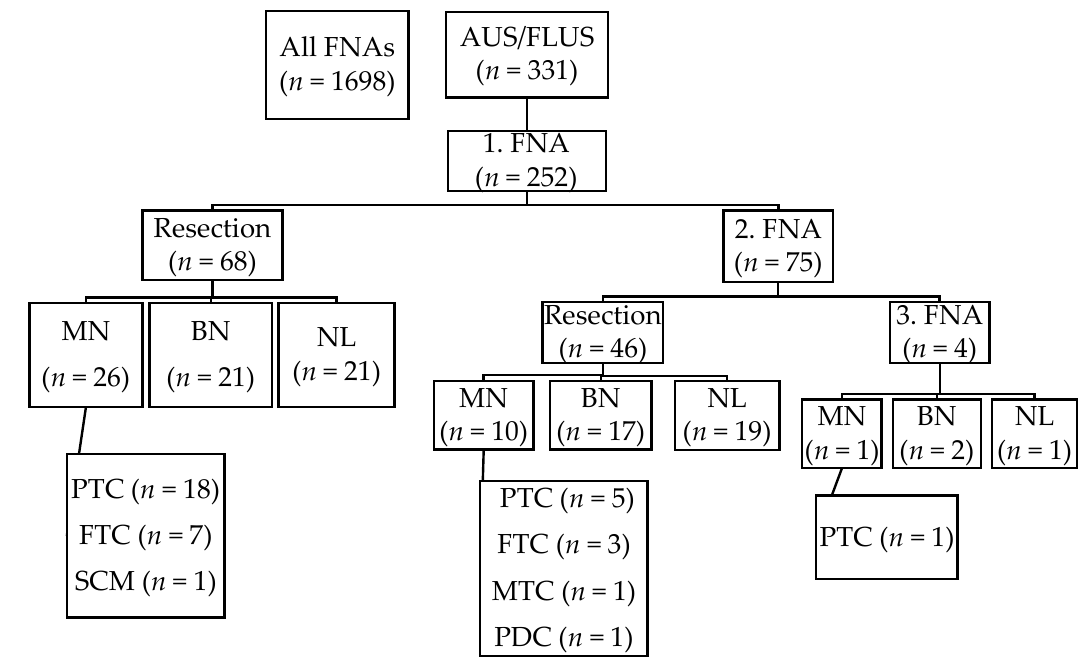
Figure 1. The outcome of AUS / FLUS cases. MN, malignant neoplasms; BN, benign neoplasms; NL, non-neoplastic lesions, PTC, papillary thyroid carcinoma; FTC, follicular thyroid carcinoma; MTC, medullary thyroid carcinoma; PDC, poorly di ff erentiated carcinoma; SCM, squamous cell carcinoma metastasis.